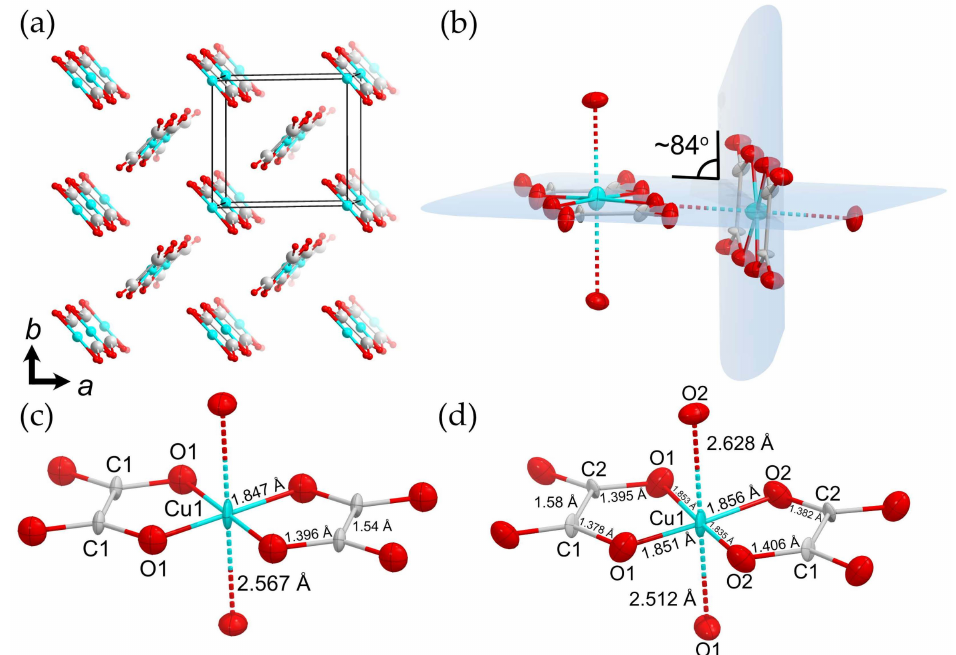
Figure 6. The crystal structure of copper oxalate ( a ); an illustration of chain inclination ( b ); a fragment of the copper oxalate chain in the orthorhombic setting ( c ); a fragment of the copper oxalate chain in the monoclinic setting ( d ). Thermal ellipsoids are drawn at 50% probability level. Legend: Cu = cyan; O = red; C =